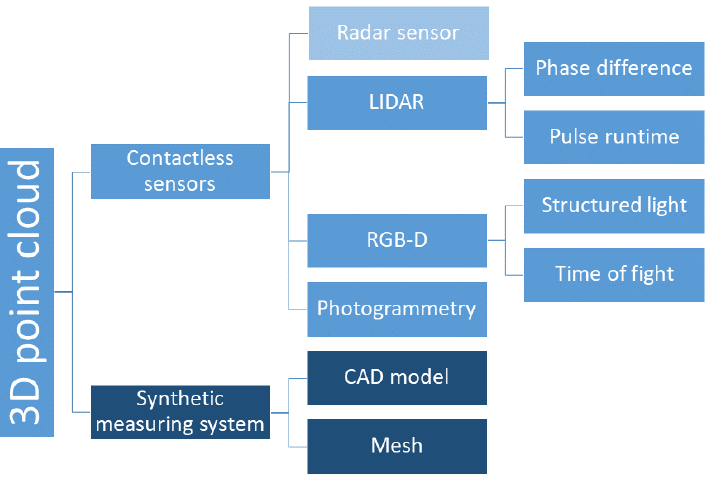
Figure 2. Capturing systems and basic data for the creation of 3D point